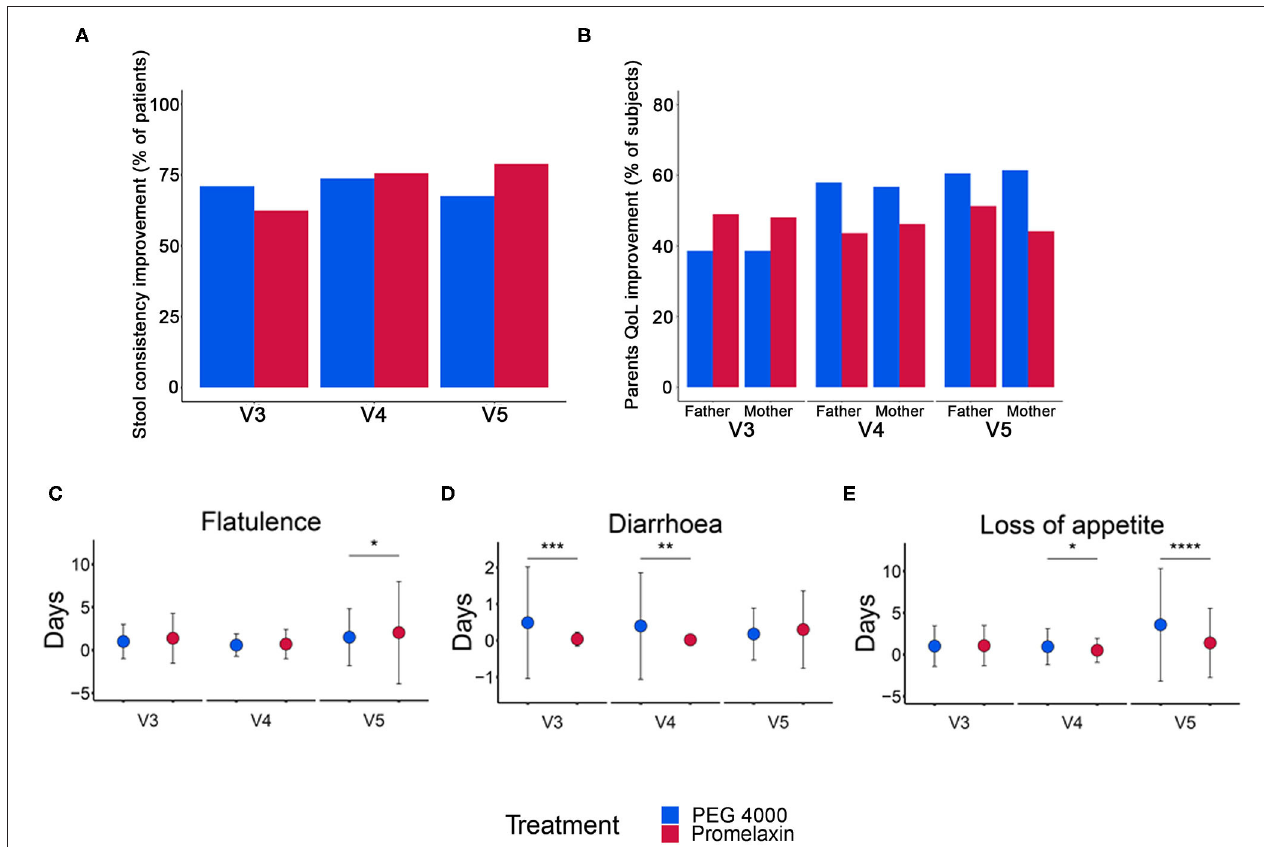
FIGURE 5 | Stool consistency, QoL improvement and gastrointestinal symptoms in the randomized arms. (A) Percentage of patients with improved stool consistency at V3, V4, and V5. (B) Percentage of parents with improved QoL at V3, V4, and V5. (C–E) Number of days (mean ± SD) with gastrointestinal symptoms at V3, V4, and V5. Data are reported as mean ± SD. * p < 0.05, ** p < 0.01, *** p < 0.001, and **** p < 0.0001. (A) V3: PEG, n = 45; Promelaxin, n = 56; V4: PEG, n = 42; Promelaxin, n = 45; V5: PEG, n = 37; Promelaxin, n = 38; (B) V3 (Father): PEG, n = 44; Promelaxin, n = 49. V4 (Father): PEG, n = 38; Promelaxin, n = 39. V5 (Father). PEG, n = 38; Promelaxin, n = 39; (B) V3 (Mother): PEG, n = 44; Promelaxin, n = 52. V4 (Mother): PEG, n = 44; Promelaxin, n = 52. V5 (Mother): PEG, n = 44; Promelaxin, n = 52. (C–E) V3: PEG, n = 45; Promelaxin, n = 56. V4: PEG, n = 40; Promelaxin, n = 47. V5: PEG, n = 40; Promelaxin, n =